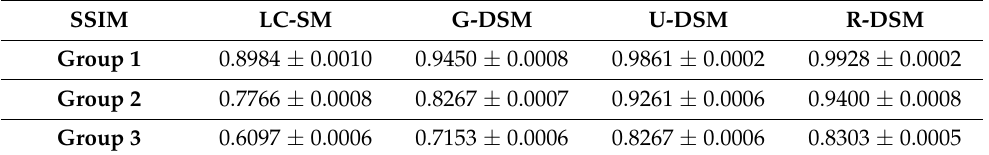
Table 4. SSIM (mean ± SD) of different DRF groups for LC-SM, G-DSM, U-DSM, and R-DSM for 99m